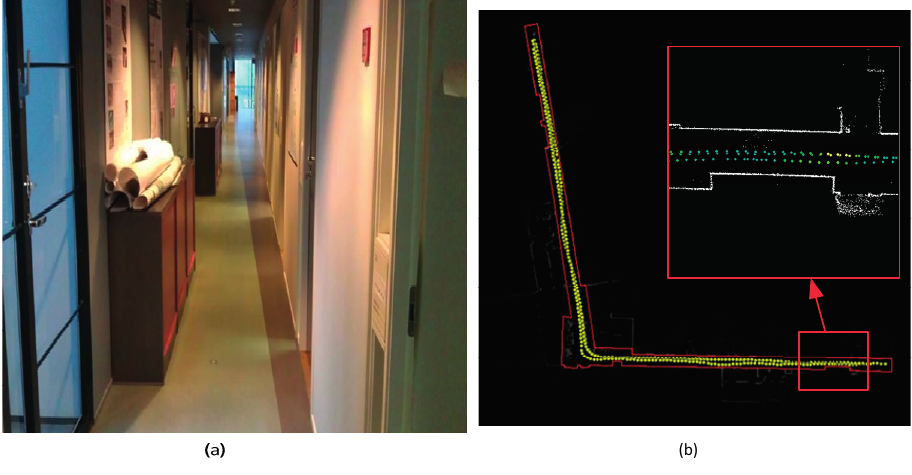
Figure 9. ( a ) Corridor in FGI; ( b ) reference point trajectories collected by